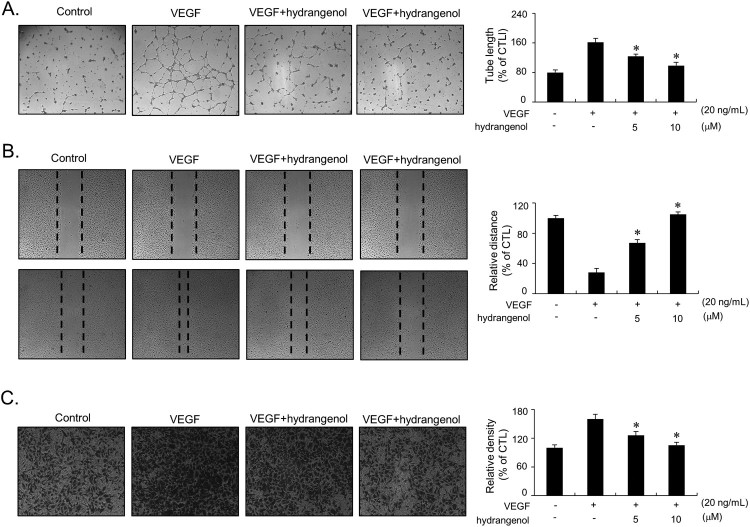
Inhibitory activity of hydrangenol against capillary-like tube formation, migration, and invasion in HUVECs stimulated by VEGF. (A) HUVECs grown on Matrigel-coated plates were treated with hydrangenol for 1 h, followed by VEGF treatment. Capillary-like tube structure was measured after 24 h using Image-Pro Plus. (B) HUVECs were incubated with hydrangenol (0, 5, and 10 μM). Cells were scratched and treated with VEGF (20 ng/mL) for 24 h. Cell morphology was photographed using an inverse light microscope. The relative migrated distance was measured and plotted on a graph and further compared with that of the control group (untreated). (C) Serum-starved HUVECs were plated on to the upper chamber of transwell plates. Cells were incubated with hydrangenol, followed by VEGF addition (20 ng/mL) and incubation for 24 h. Cells passing through the transwell membrane were visualized and quantified by staining with crystal violet. Values in the bar graphs were presented as a fold change in comparison with those of the control group (untreated). Statistical analysis was performed using unpaired Student's t-test for VEGF alone vs. VEGF + hydrangenol-treated groups. Values were presented as ±SEM of the three independently repeated experiments. Values at *p < 0.05 were considered significant.